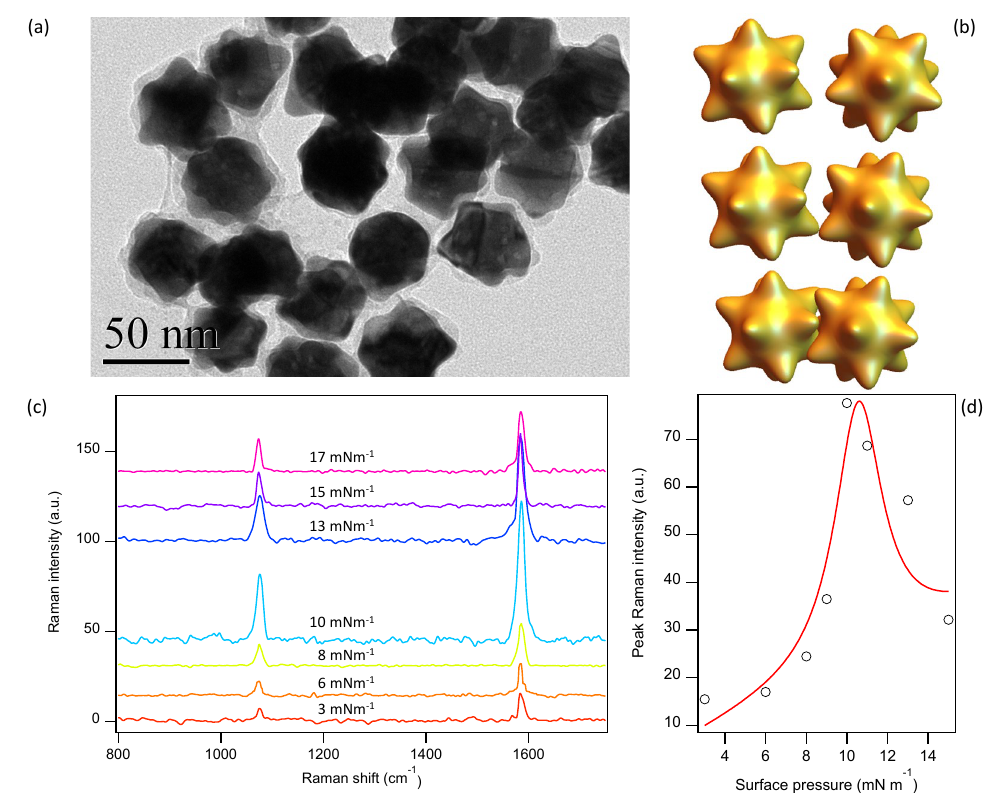
Figure 4. ( a ) TEM image of synthesized gold nanostars. ( b ) Sketch of gold nanostars as the lateral packing density is increased, leading to overlaps that degrade the SERS performance. ( c ) SERS spectra of 4-MBA adsorbed on gold nanostars prepared at different lateral pressures and 8 min of gold electroless plating time. ( d ) Height of the SERS peak at 1588 cm − 1 at different surface pressures. The line through data is a guide for the